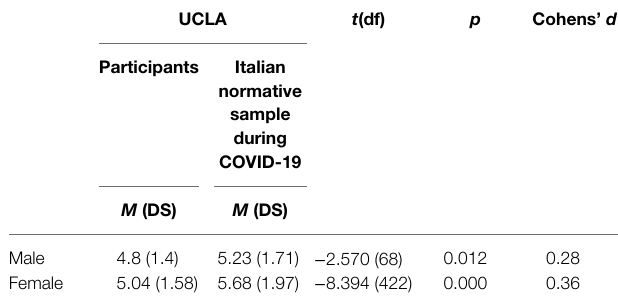
TABLE 6 | Loneliness comparison between the average values of the participants and the average values of the first wave (Rania and Coppola, 2021).